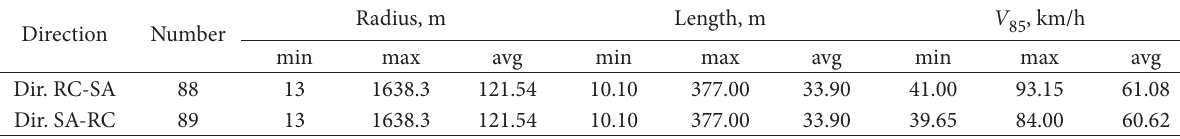
Table 2. Statistics for curves